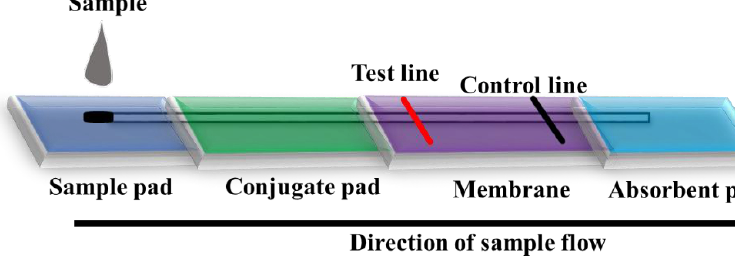
Figure 6. Flow diagram of the lateral flow assay (LFA) detection method.